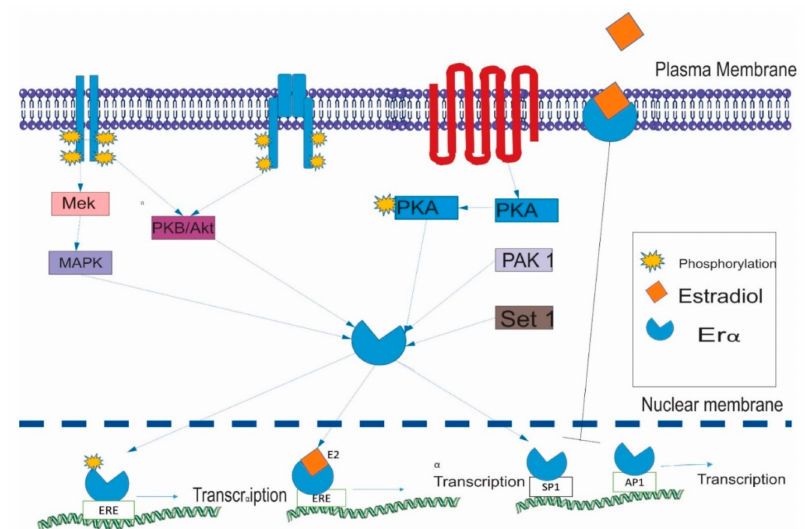
Figure 2. Schematic diagram showing activation of estrogen receptor alpha in both ligand dependent and independent ways. ERs can mediate transcription of target genes either by binding to estrogen response elements (ERE) or binding to other transcription factors such as SP1 and AP1 [55].